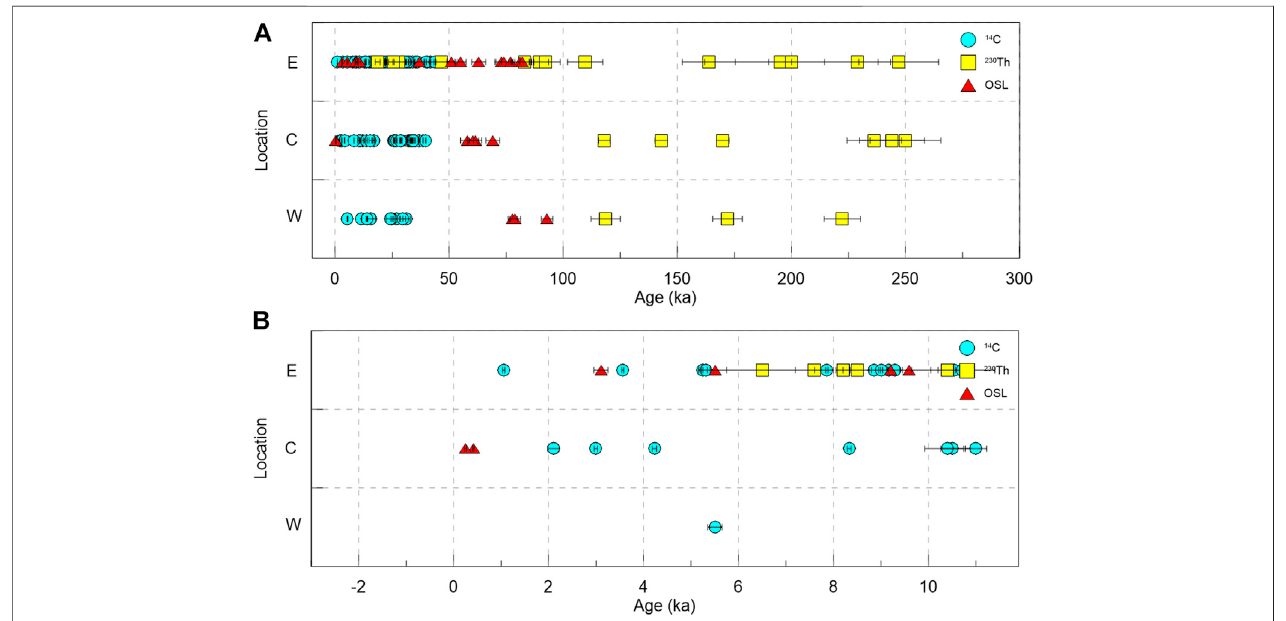
FIGURE1| SummaryofpublishedchronologicaldataofthesaltlakesintheQaidamBasinoverthepast250 ka (A) and10 ka (B) .Therecordsaremainlyfromthe east (E), center (C), and west (W) of the Qaidam Basin. For more detailed information, see Supplementary Table S1 in the supplementary material.